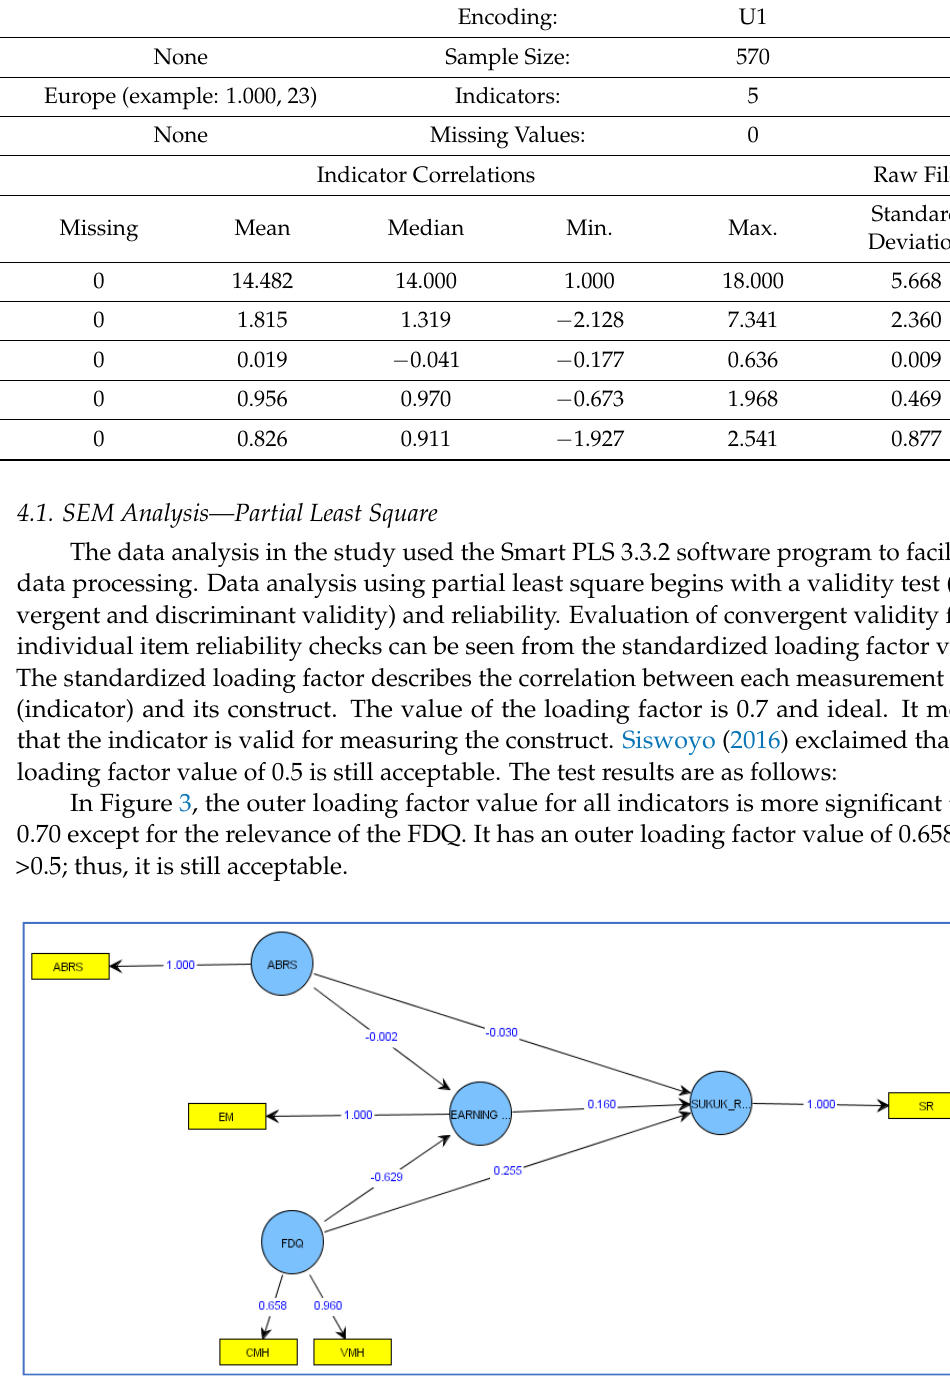
Figure 3. Outer and Inner Model.